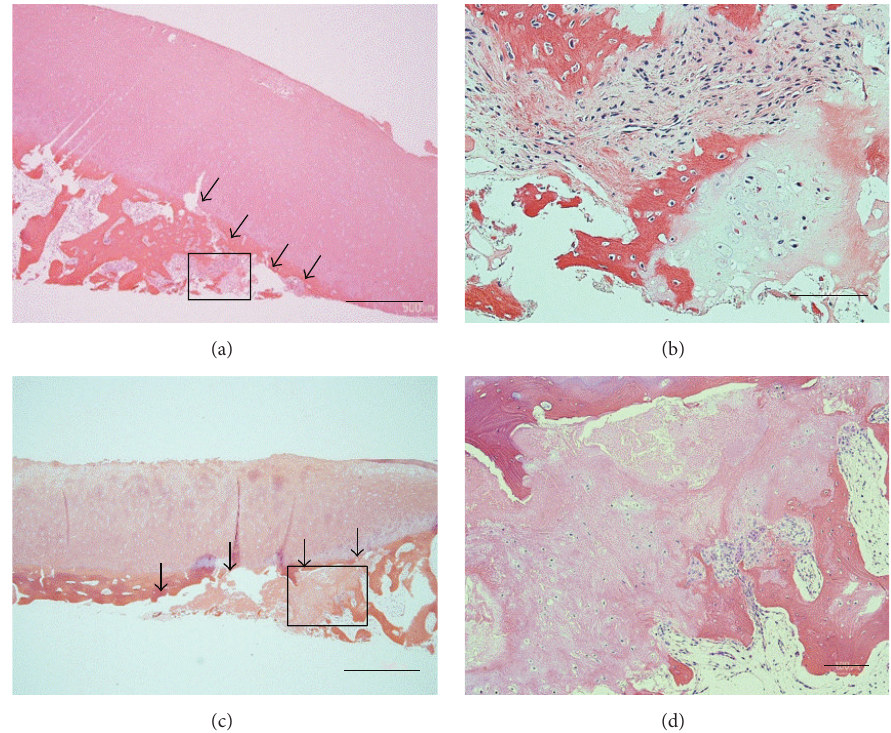
Figure 5: Histological findings (hematoxylin and eosin staining). (a) MFC specimen (original magnification, × 20; bars = 1000 𝜇 m), (b) magnification of the square region in (a) (original magnification, × 100; bars = 200 𝜇 m). (c) MTP specimen (original magnification, × 20; bars = 1000 𝜇 m), and (d) magnification of the square region in (c) (original magnification, × 40; bars = 100 𝜇 m). Histological examination of both specimens revealed fracture lines